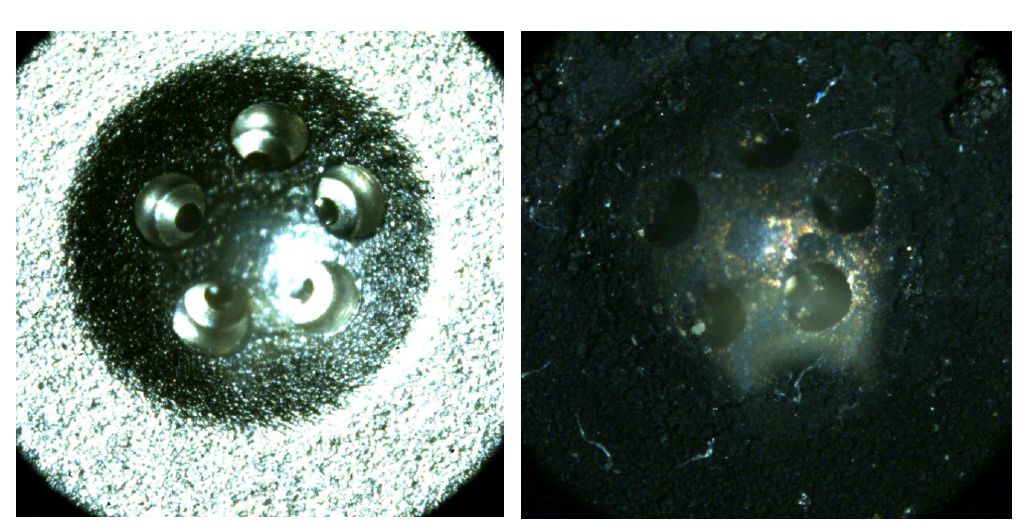
Figure 3. Images of clean and fouling injector.